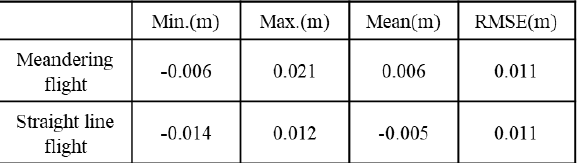
Figure 9. Target area of the practical experiment